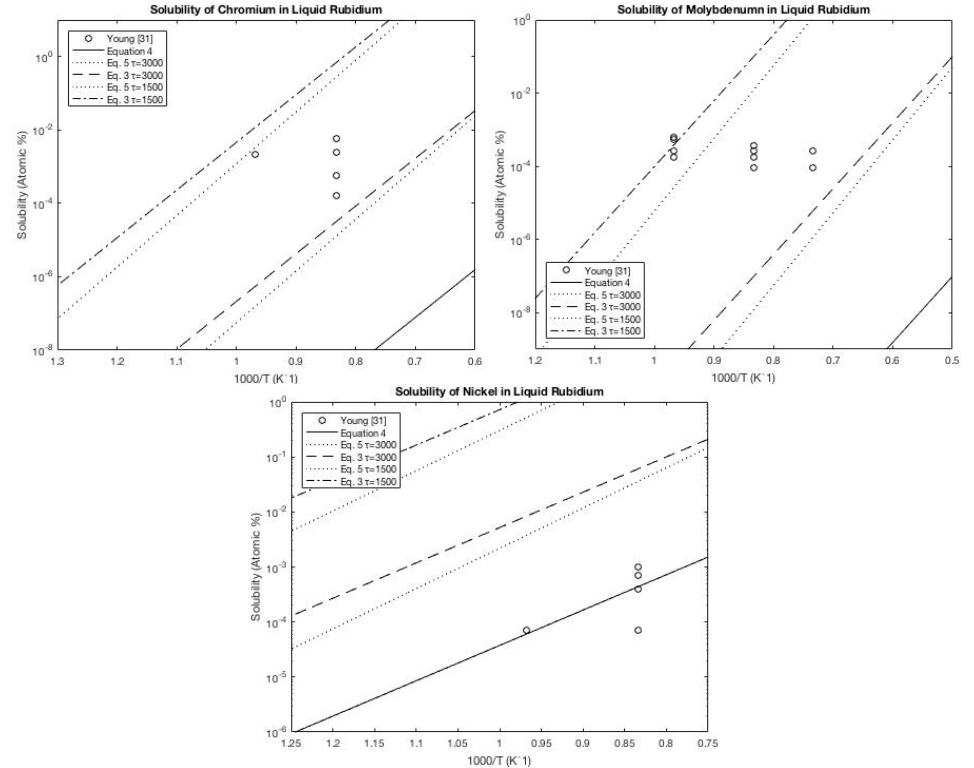
Figure A4. Solubility of additional transition metals in liquid rubidium compared to the model.